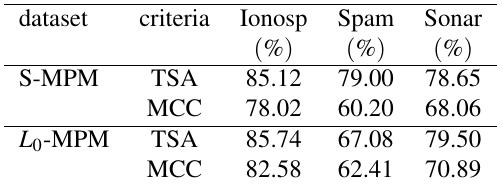
Table 5. Comparison of TSA and MCC between L 0 -MPM and S-MPM